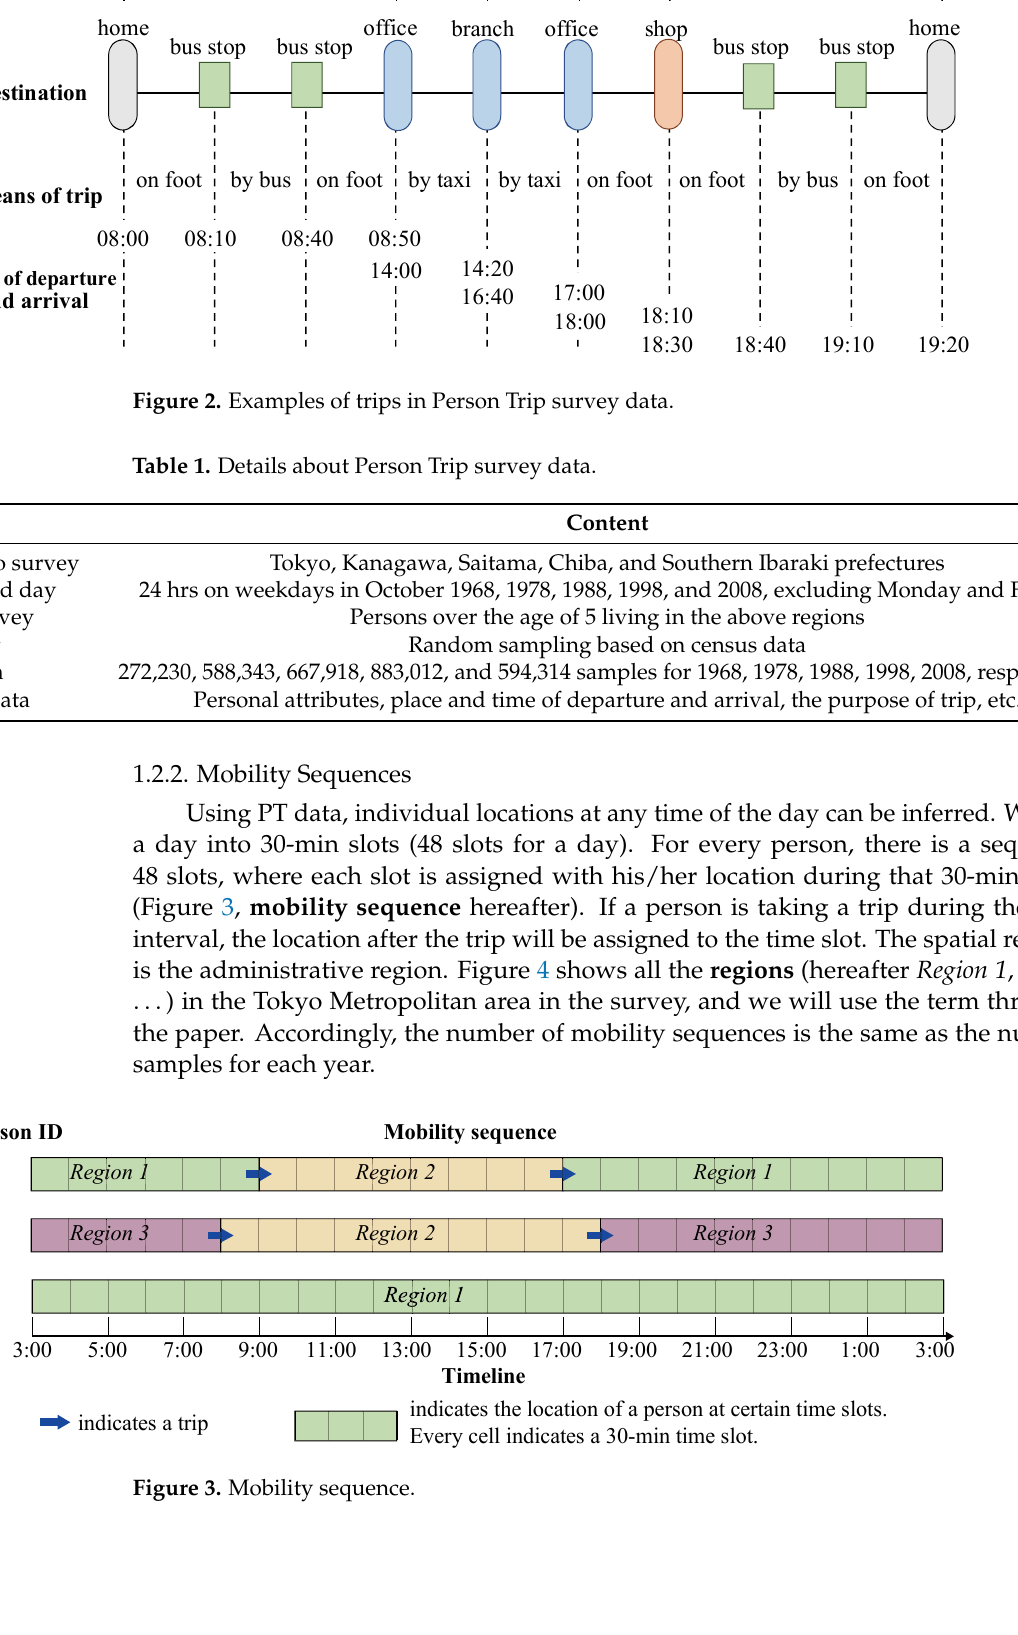
Figure 4. Survey regions. 2. The Model for Reproduction By considering the temporal similarity of individual travel behaviors, we cluster peo ‐ ple into four groups using hierarchical clustering algorithms (Table 2). Since this paper mainly introduces the reproduction method and the energy concept, the detail of the al ‐ gorithm is out of focus. For each year, people are classified into four groups based on their ages and occupations, and the reproduction model is validated for each group of people in each year. To reproduce mobility sequences that are spatially and temporally similar to the original mobility sequences, we develop a two ‐ step time ‐ varying Markov Chain model. The model is detailed in Section 2.1, and in Section 2.2, the performance is evalu ‐ ated spatially and spatiotemporally. Table 2. Four groups of people. Group ID